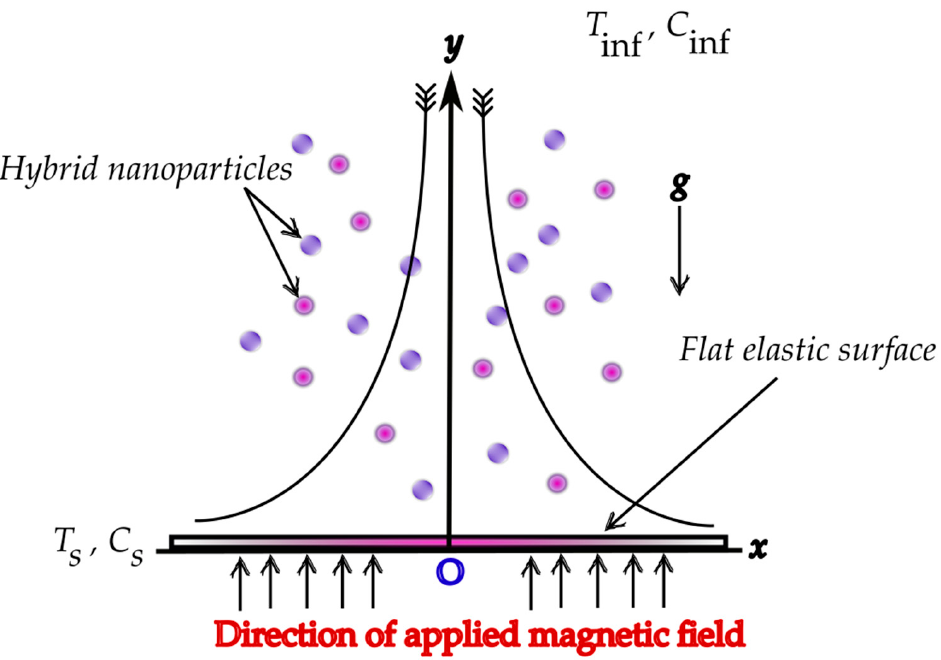
Figure 1. Geometrical structure of the water-based hybrid nanofluid flow over a flat elastic surface with an extrinsic magnetic field.